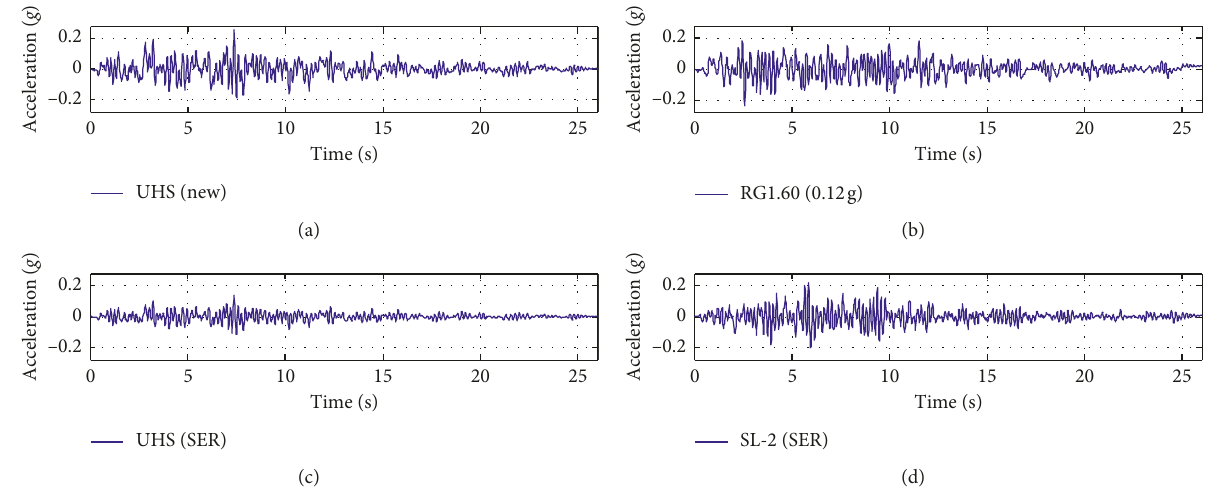
Figure 16: Interlayer bending moment.